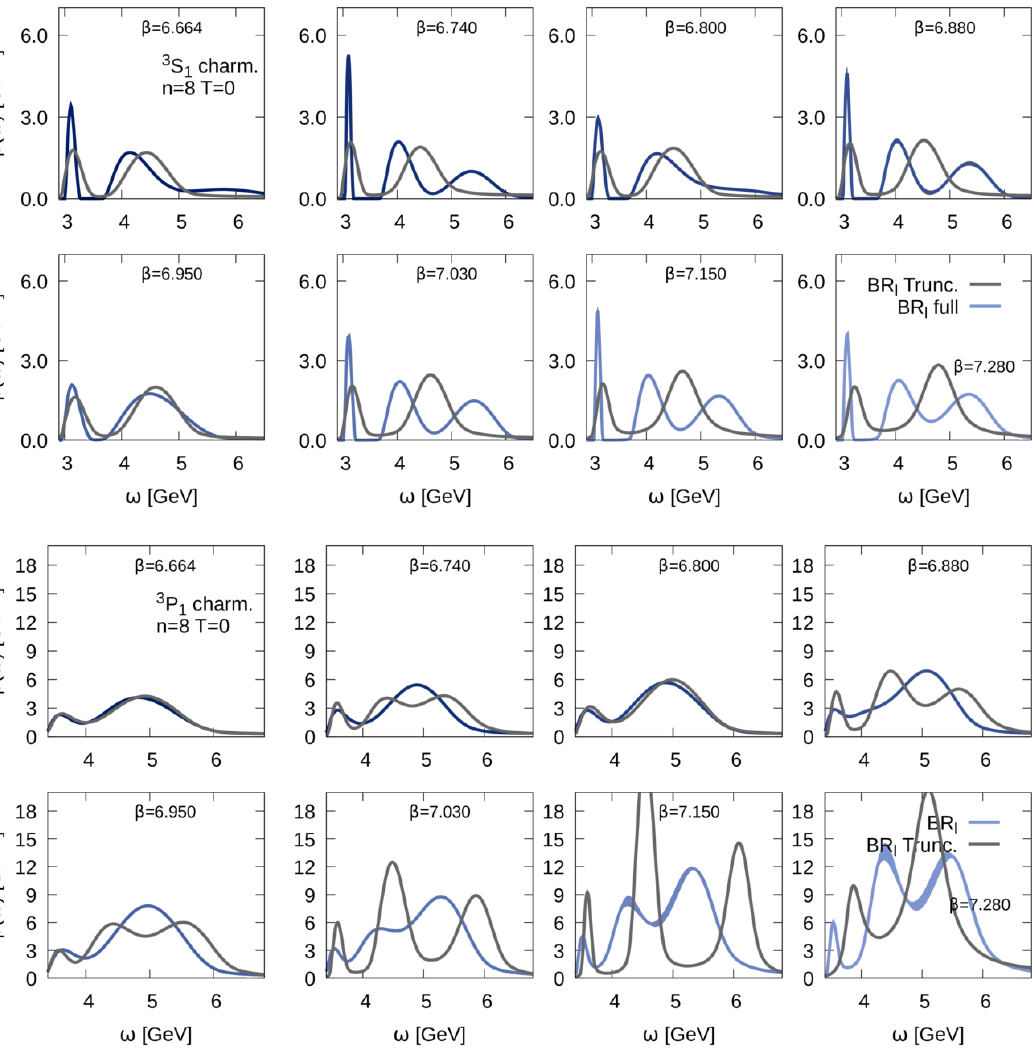
Figure 39 . In(cid:13)uence on the smooth BR reconstruction from a truncation of the low-temperature simulation data to the same (cid:28) max =a (cid:28) = 12 Euclidean time extent available at (cid:12)nite temperature. The spectra shown here correspond to the 3 S 1 (top) and 3 P 1 channel of charmonium with the full reconstruction given by colored solid lines, while the result after truncation is given by the gray solid